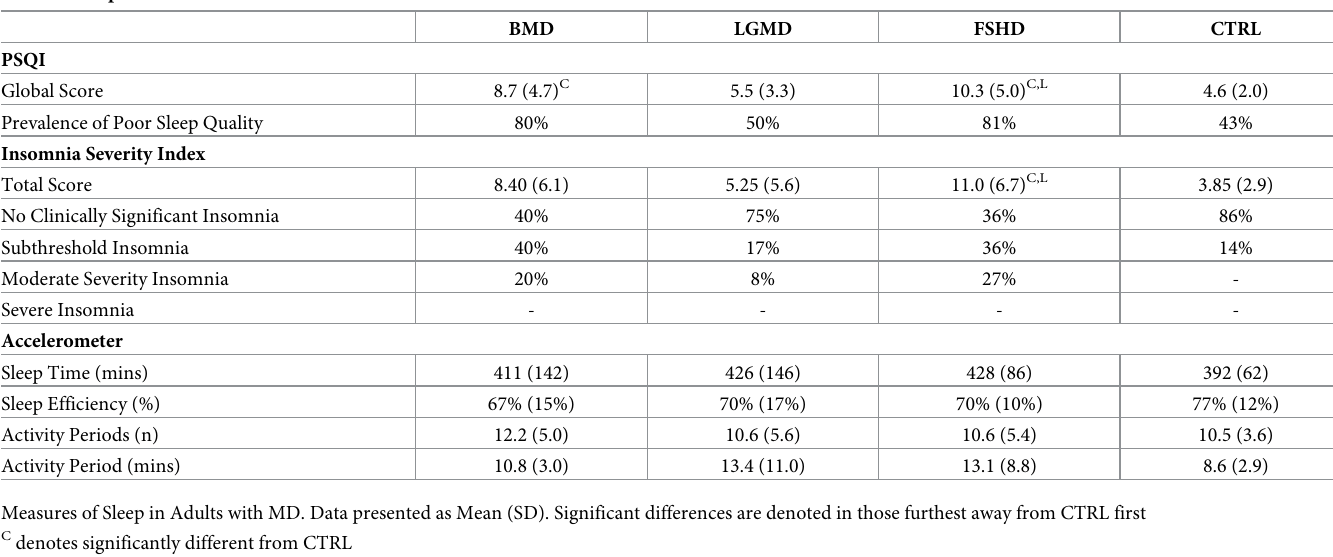
Table 2. Sleep measures in adults with MD.